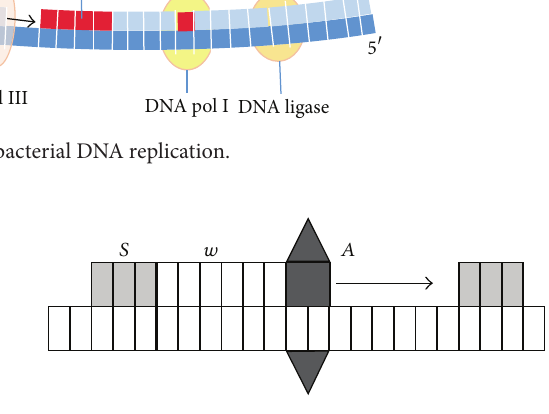
Figure 3: The simulation of a synthesis process with a